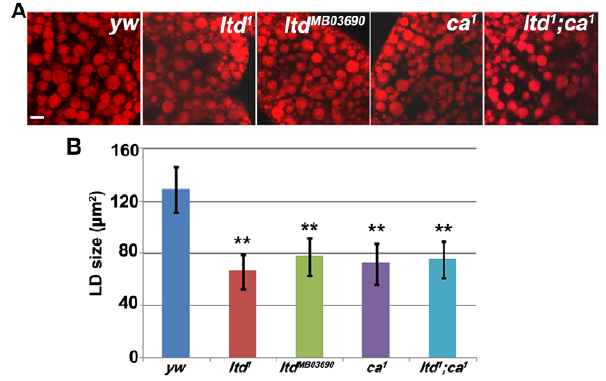
Figure 2. Lipid droplet size is reduced in Rab32/ltd and Rab32 GEF/ca mutants. (A) Nile red staining of lipid droplets in wandering stage third instar larval fat body cells. Rab32/ltd and Rab32 GEF/ca mutants have smaller lipid droplets compared to the control. Scale bar: 10 m m. (B) Quantification of the effects of Rab32/ltd and Rab32 GEF/ca single mutants and ltd;ca double mutants. The error bars represent the standard deviation. **: P , 0.001.